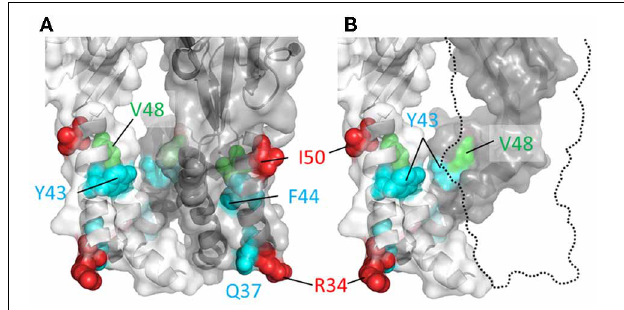
FIGURE 3 | Mapping P2X2R TM1 side-chains accessible to water-soluble thiol-reactive agents using SCAM. TM domain regions shown with all subunits present (A) or the third subunit omitted (B) . Side chains at which cysteine substitution renders the mutant receptor sensitive to current modification by thiol-reactive agents are shown as ball models. Color coordination is as follows: Red, mutant currents modified by brief 5s application of Ag + only; Green, mutant currents modified by brief 10s application to MTSET + ; Cyan, mutant currents modified by prolonged ( > 1min) exposure to thiol-reactive